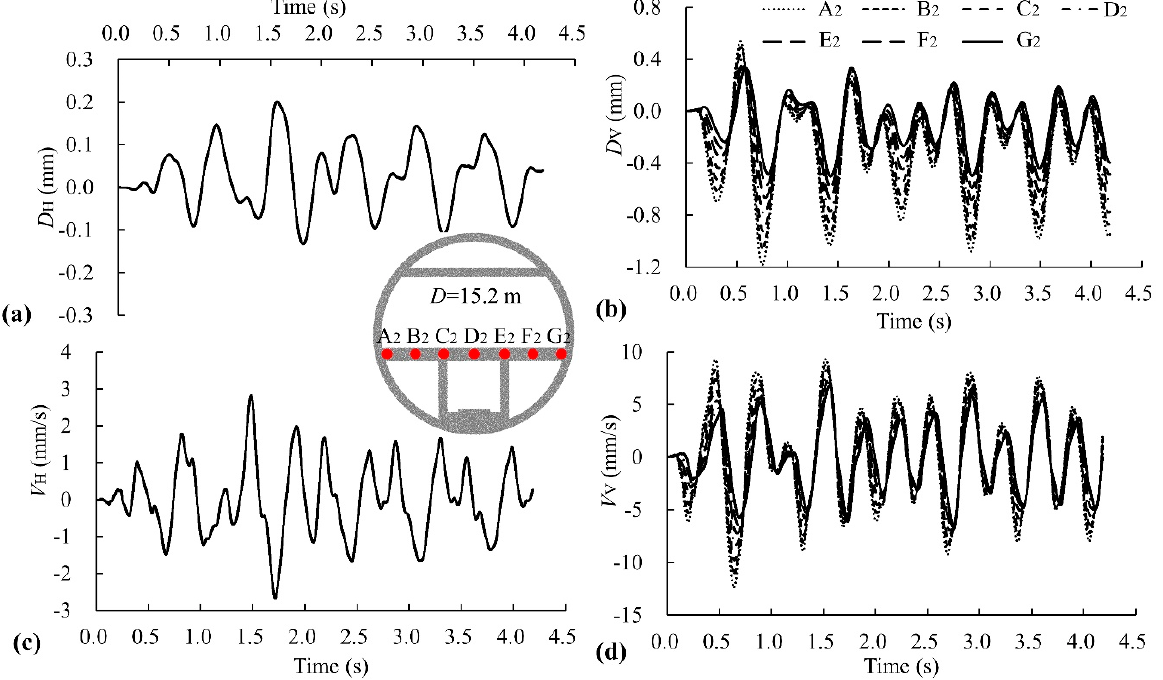
Figure 10. Displacement and velocity of seven measurement points (A 2 , B 2 , C 2 , D 2 , E 2 , F 2 and G 2 ) in Wall_2 of T2: ( a ) D H ; ( b ) D V ; ( c ) V H ; and ( d ) V V.